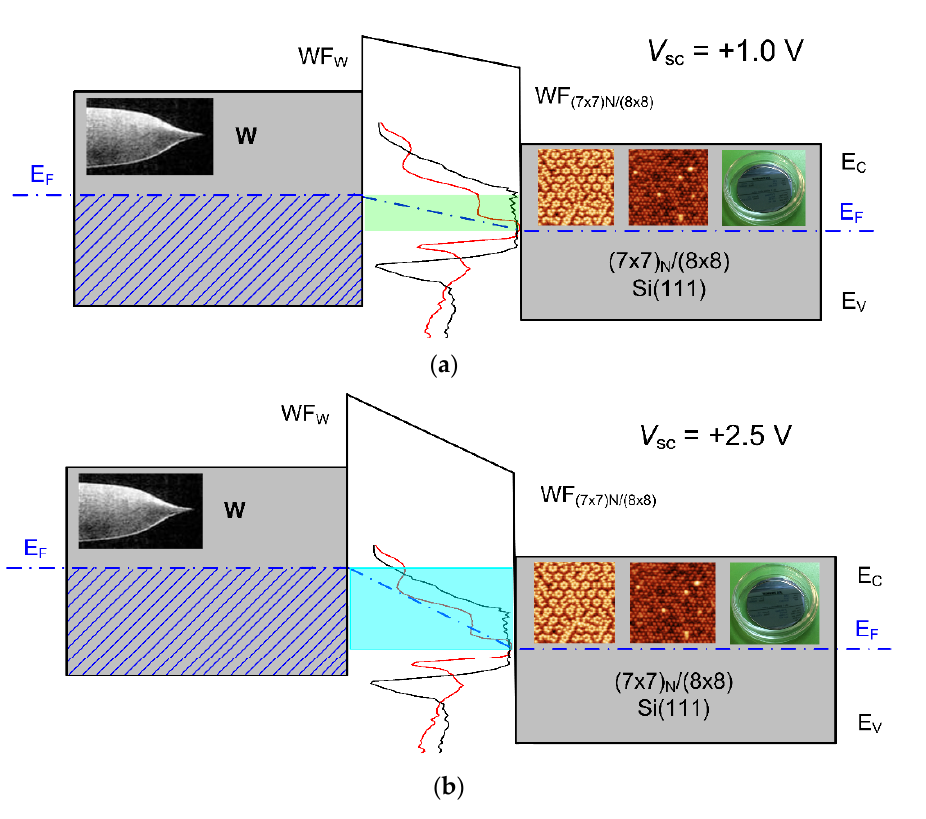
Figure 7. Schematic representation of tunnel current measurements for the different voltage values +1.0 V ( a ) and +2.5 V ( b ).